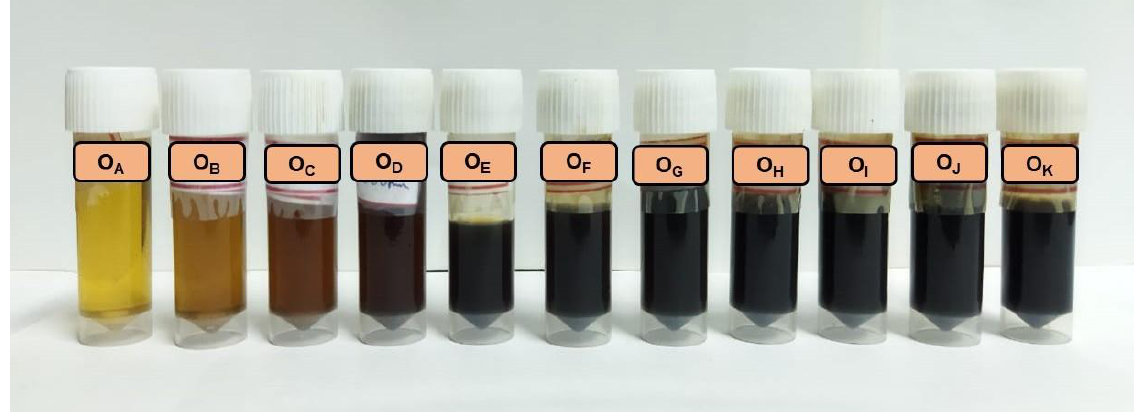
Figure 1. Engine oil samples.